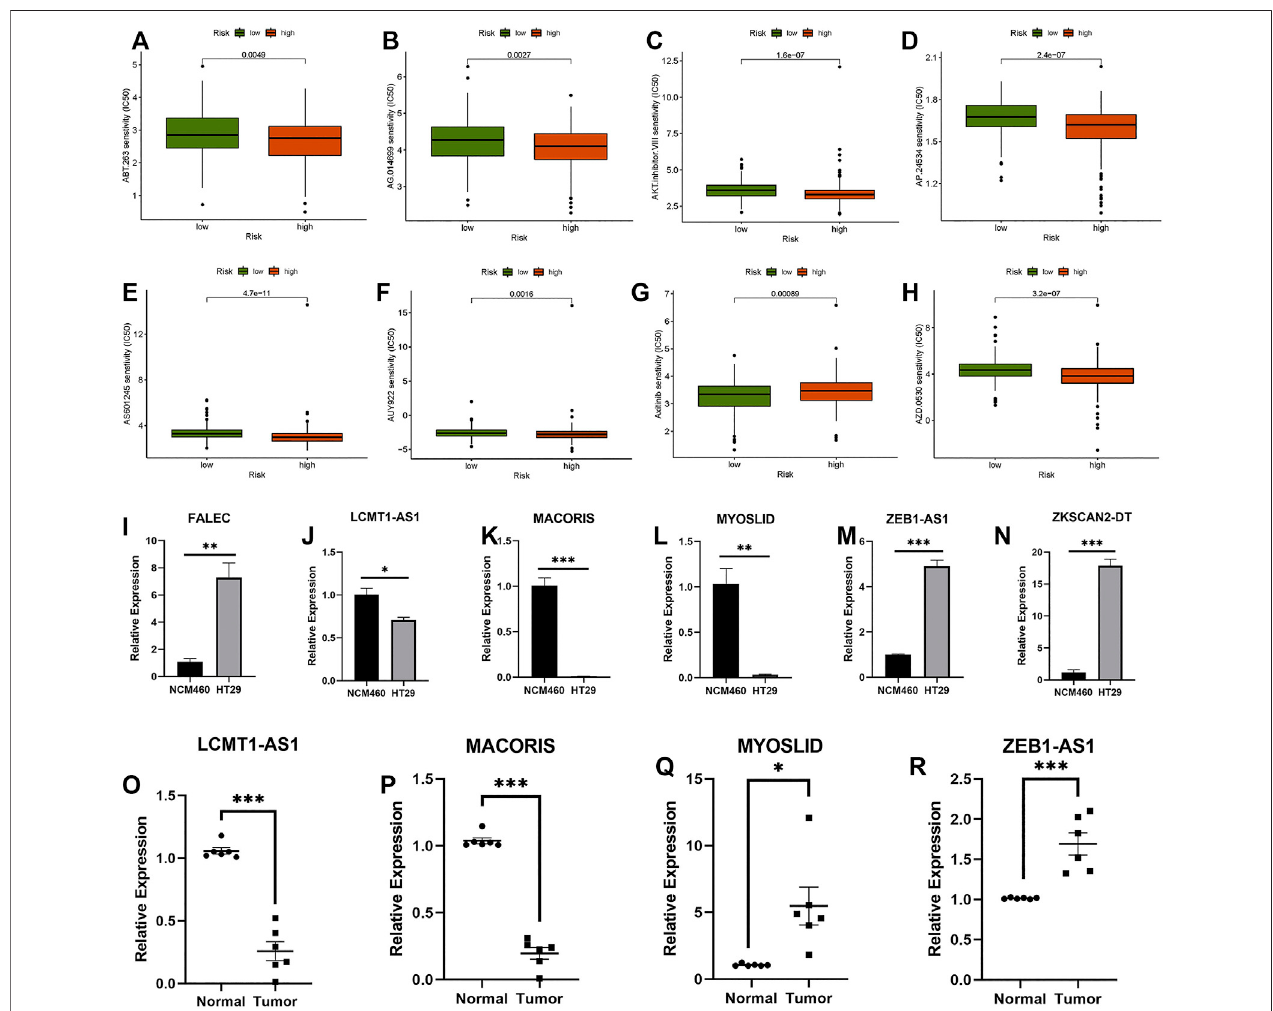
FIGURE 10 | Prediction of potential compounds in the treatment of CC and qRT – PCR. (A) ABT.263. (B) AG.014699. (C) AKT.inhibitor.VII senstivity. (D) AP.24534. (E) AS601245. (F) AUY922. (G) Axitinib. (H) AZD.0530. (I – N) Relative expression of FALEC, LCMT1-AS1, MACORIS, MYOSLID, ZEB1-AS1, and ZKSCAN2-DT in NCM460, and HT29 cell line. (O – R) Relative expression of LCMT1-AS1, MACORIS, MYOSLID, and ZEB1-AS1 in normal and tumor tissue. * p < 0.05, ** p < 0.01, *** p <